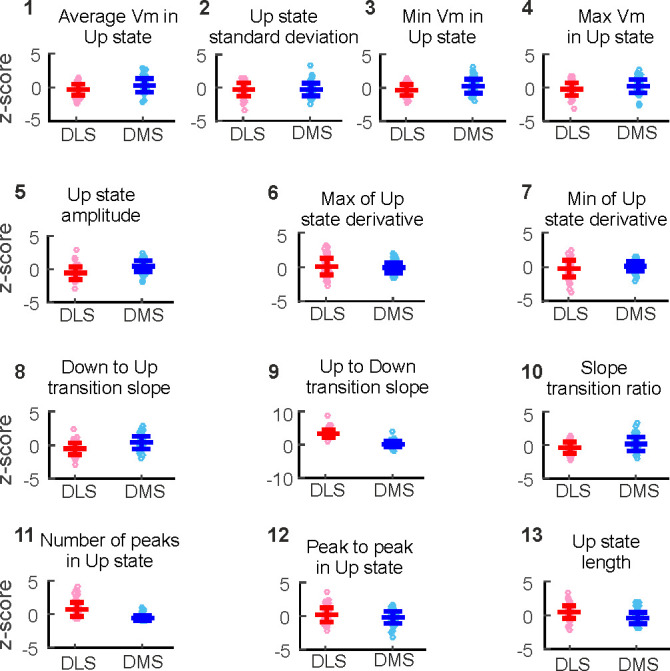
Z-scoring of the SWO features.Z-score transformation of the computed features of the SWO that were used for the classification of DLS- and DMS-MSNs in Figure 3A. p Values are the same as in Figure 3A.